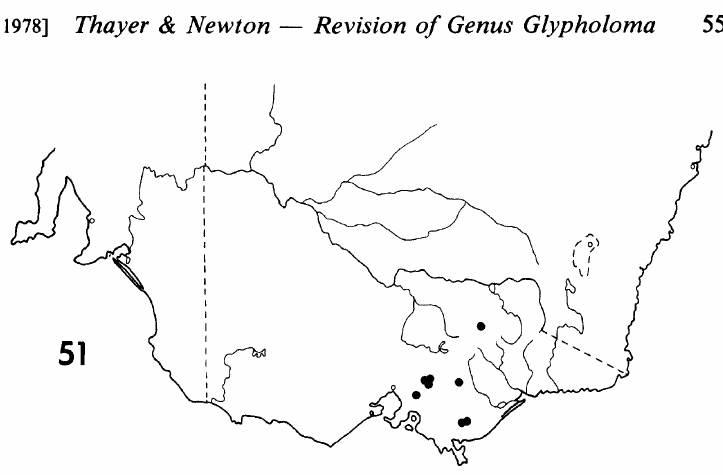
Fig. 51. Victoria, Australia, with dots showing locality records for Glypholoma